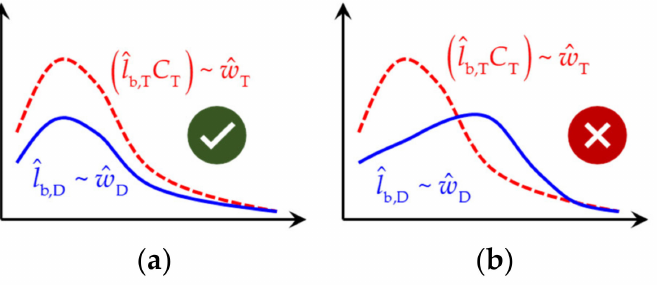
Figure 4. Illustration of matching the performance ( a ) acceptable and ( b )